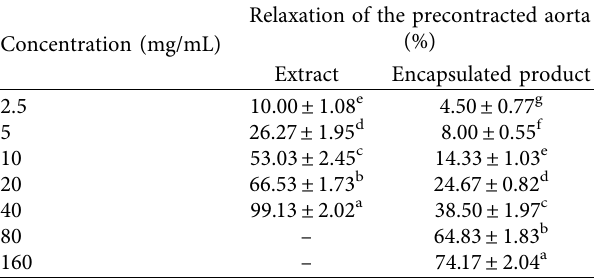
Superscripted letters in the column indicate the presence of the significant differences ( P < 0 . 05) among the values which showed different concen- trations of the